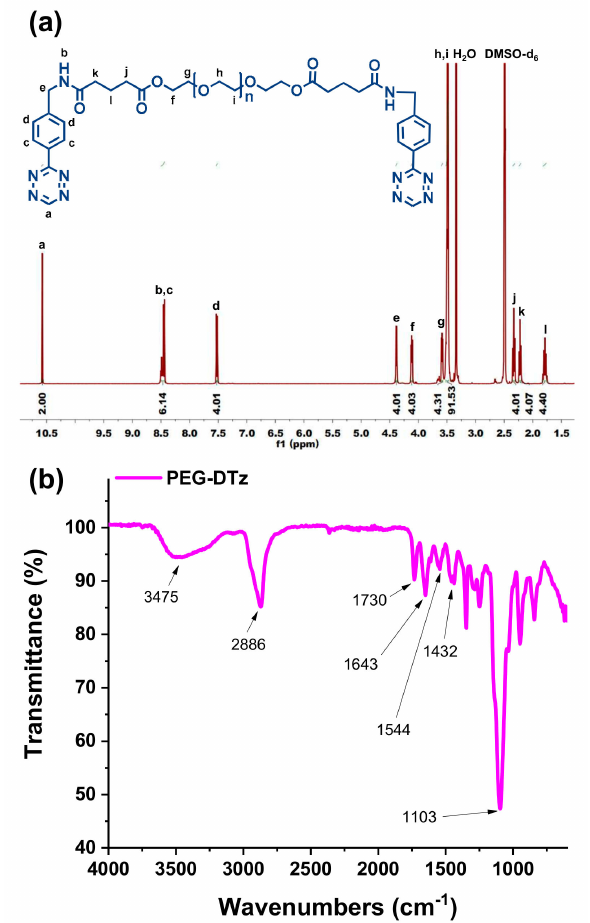
Figure 1. Characterization of the PEG-DTz cross-linker. ( a ) 1 H NMR spectrum and ( b ) FTIR spectrum. The 1 H NMR peak at 4.13 ppm indicates the protons next to the ester linkage, rep- resenting successful occurrence of the reaction. Whereas, repeating ethylene protons of PEG can be identified by the peaks at 3.51 ppm. The structure of the PEG-DTz was further validated by FTIR, demonstrating the C-H stretching of aromatic rings at 3475 cm − 1 and the C-H stretching of PEG at 2886 cm − 1 . The C=O stretching of carbonyl groups